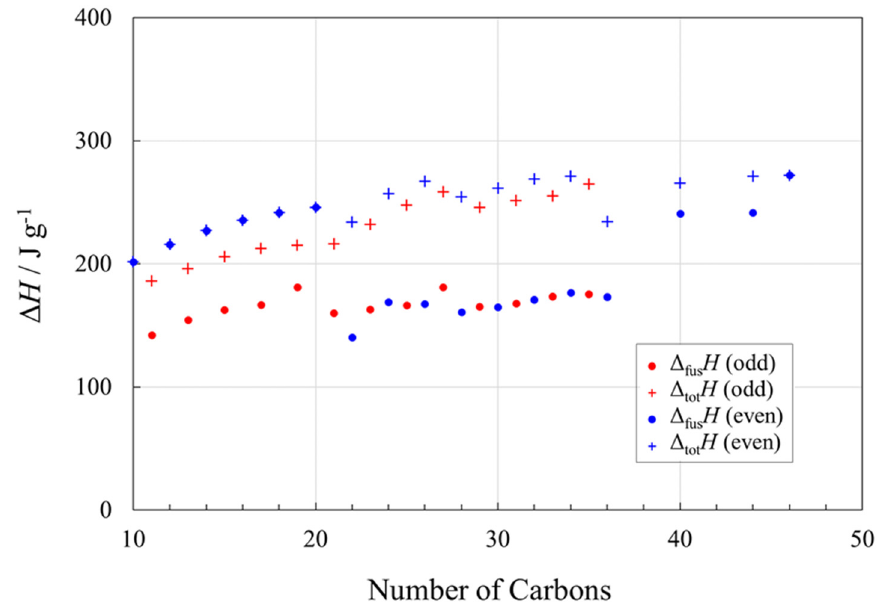
Figure 5. Enthalpy changes ( Δ H in J g − 1 ) associated with phase transitions in n -alkanes (paraffins), as a function of chain length, n . Circles ( • for even n ; • for odd n ) represent the enthalpies of fusion, ∆ fus H , and crosses (+ for even n ; + for odd n ) represent the total enthalpy changes of fusion plus that from solid–solid transition(s), if present, ∆ tot H . For even n ≤ 20, ∆ fus H = ∆ tot H . See Supplementary Information for data and data sources.